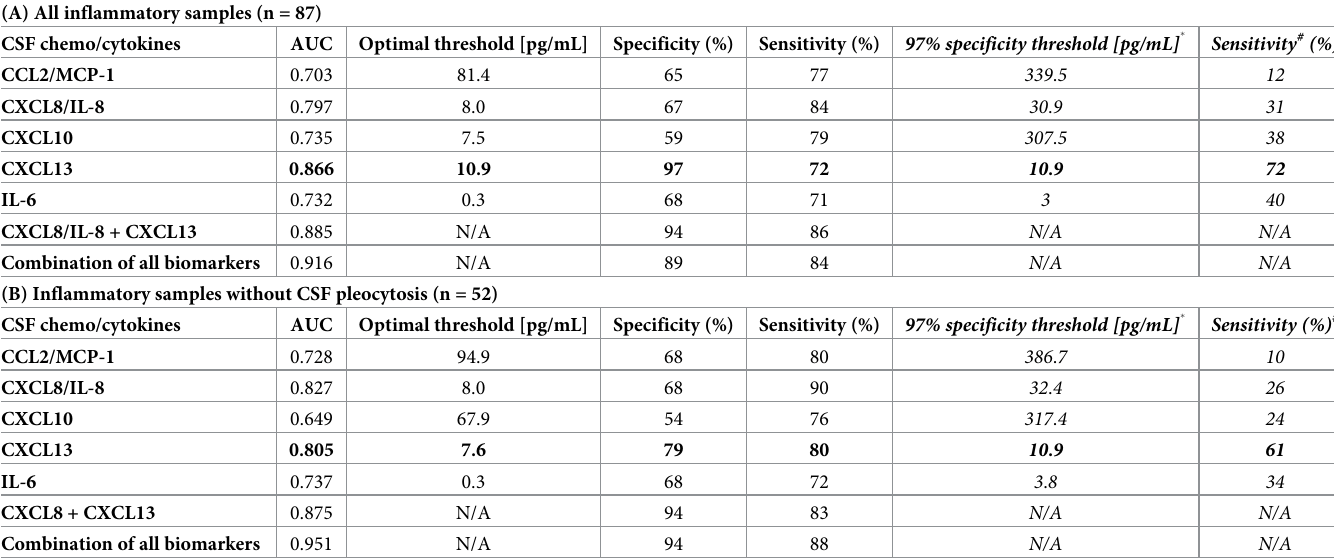
Table 4. Clinical utility of CSF chemo/cytokine biomarkers for the recognition of